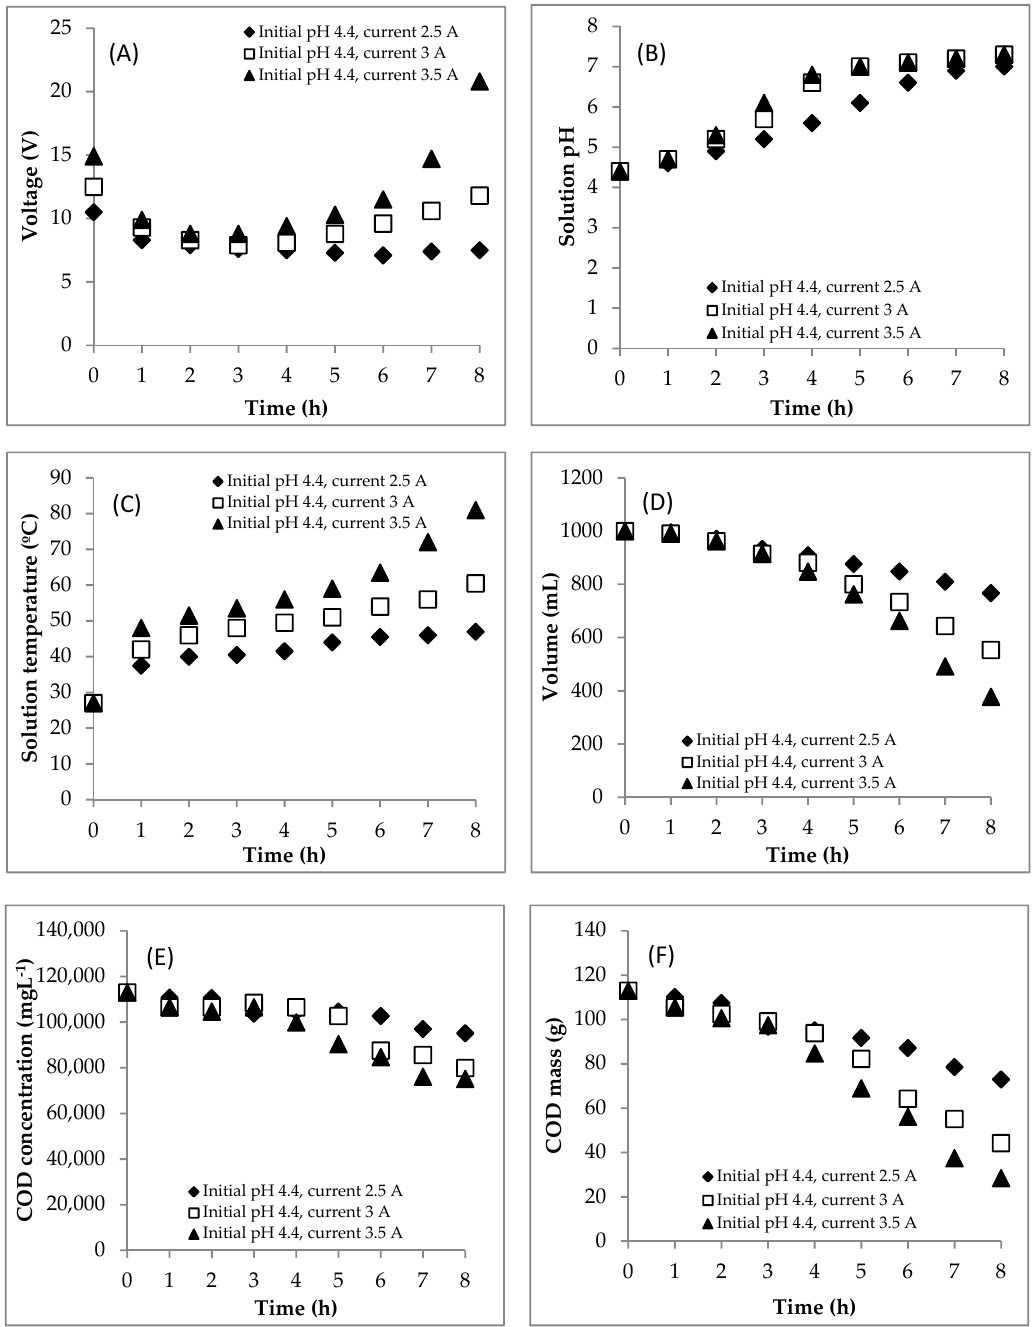
Figure 1. Effect of the current on changes of ( A ) voltage, ( B ) pH, ( C ) temperature, ( D ) volume, ( E ) chemical oxygen demand (COD) concentration and ( F ) COD mass during the electrocoagulation (EC) process. Initial COD of 112,948.5 mgL − 1 ; initial pH of 4.4; initial temperature of 27 °C.